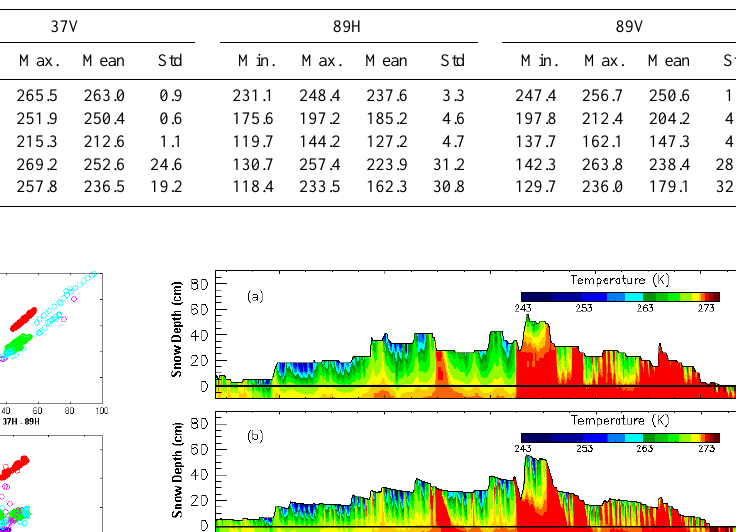
Table 1. Observed statistics of brightness temperature for snow conditions.